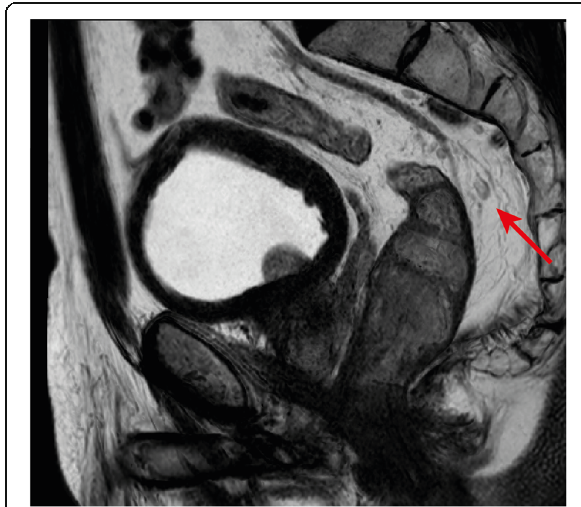
Fig. 9 Normal distribution of lymph nodes in the mesorectum (sagital minimum intensity projection). Lymph nodes are more numerous and larger in the high posterior mesorectum (arrow points to the largest lymph node but a few more are visible